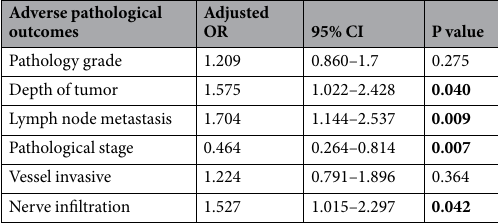
Table 3. Logistic regression analysis of PDW and its predictive value for adverse pathological